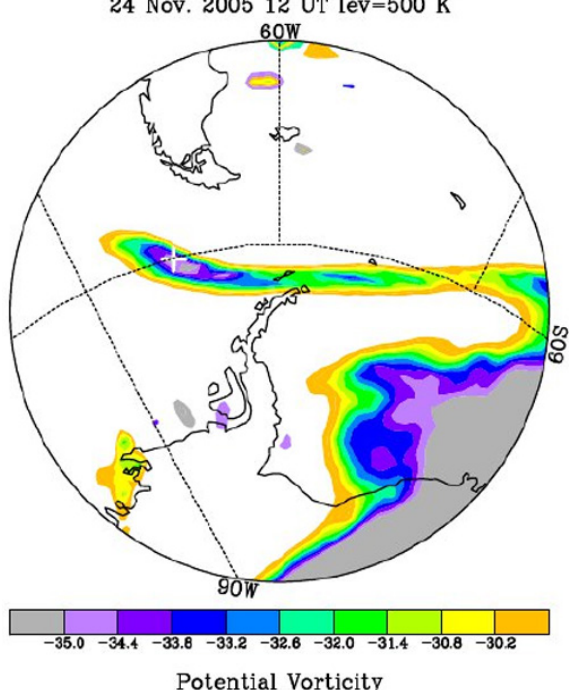
Fig. 4. A zoom for the isentropic potential vorticity distribution from ECMWF around the location of the tongue at 500K on 12:00UTC, 24 November 2005. The cross indicates the location of the balloon.